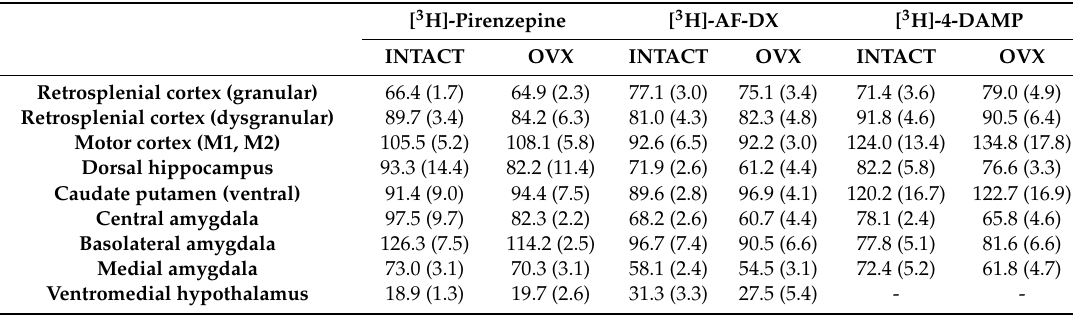
Table 1. Mean (S.E.M.) cholinergic muscarinic receptor binding density (fmol / mg estimated tissue equivalent) in intact and ovariectomized (OVX) rats in nine brain regions ( n = 3–8 per group). [ 3 H]-Pirenzepine, [ 3 H]-AF-DX 384, and [ 3 H]-4-DAMP were used to label M 1 , M 2 / M 4 , and M